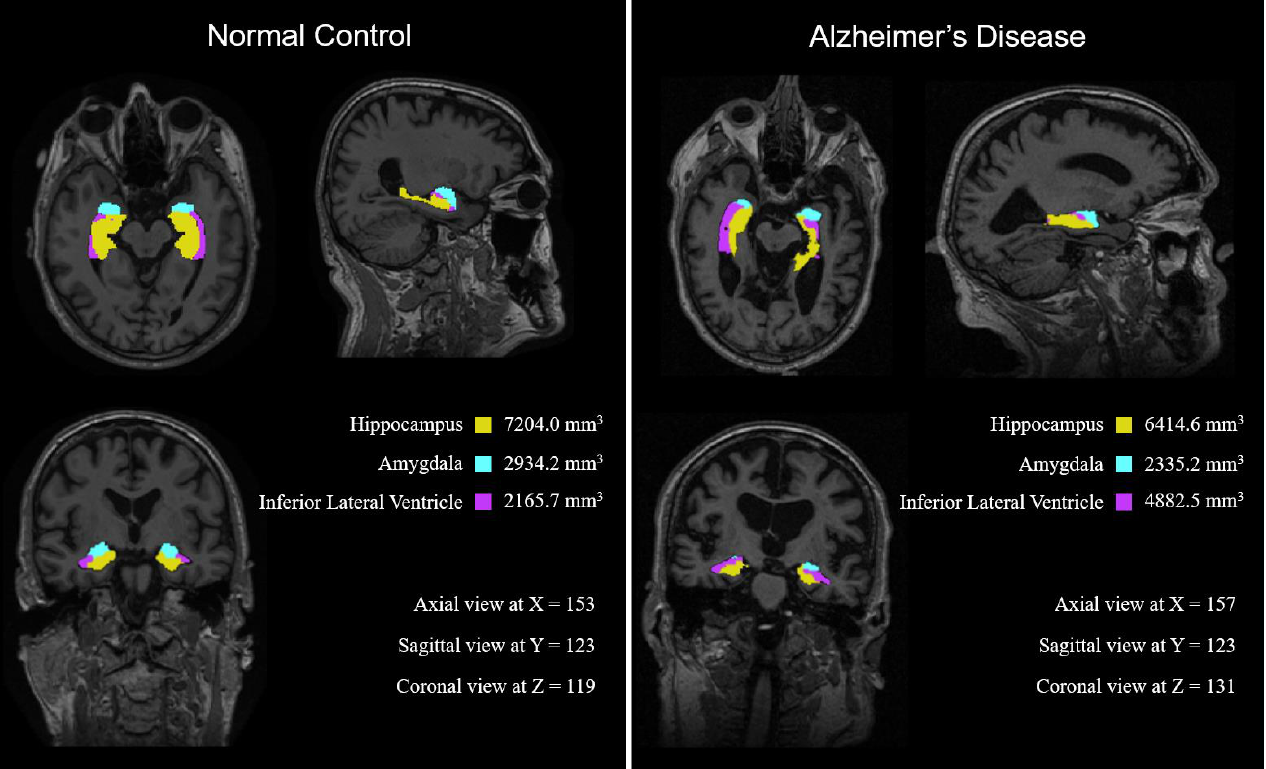
Figure 6. Two representative MRI images from the NC and AD groups. The three areas identified are marked as follows: Hippocampus: Yellow, Amygdala: Cyan, and Inferior Lateral Ventricle: Purple). Notably, the NC’s hippocampus and amygdala are larger and the inferior lateral ventricle is smaller than that of the AD subject.